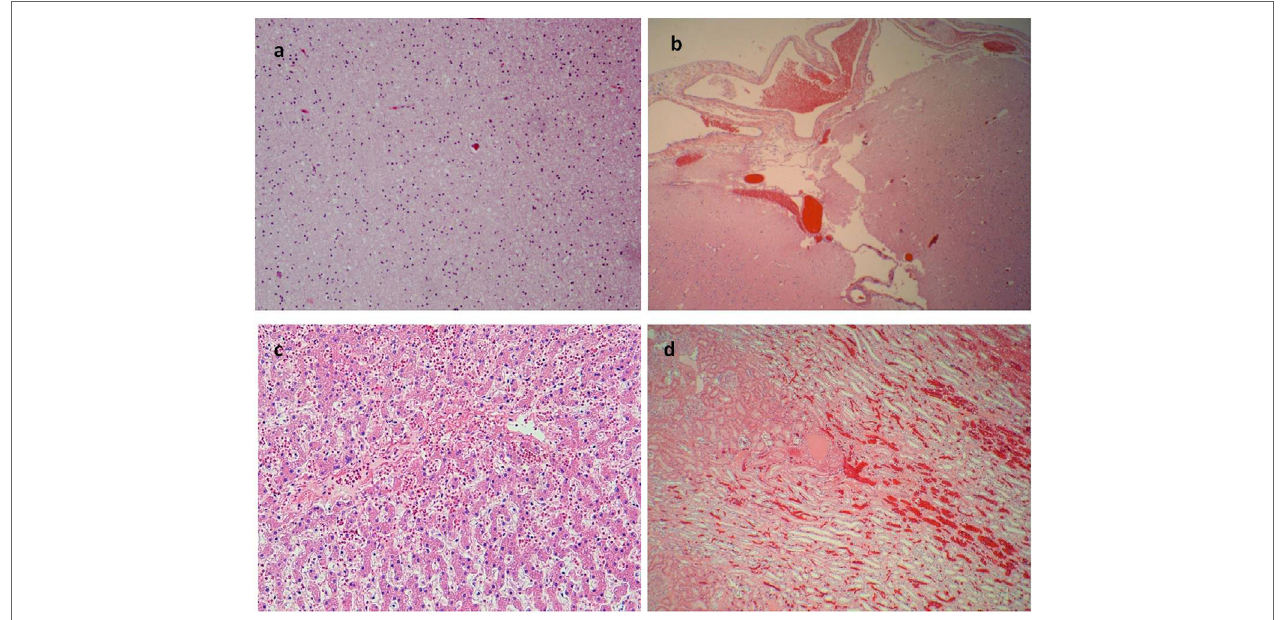
FIgURe 4 | More signs of asphyxia. (a) Brain edema (E/E 40 × ). (B) Congestion of subdural blood vessels (E/E 10 × ). (C) Edema and erythrocytes in the liver sinusoid (E/E 40 × ). (D) Congestion of kidney vessels (E/E 20 ×